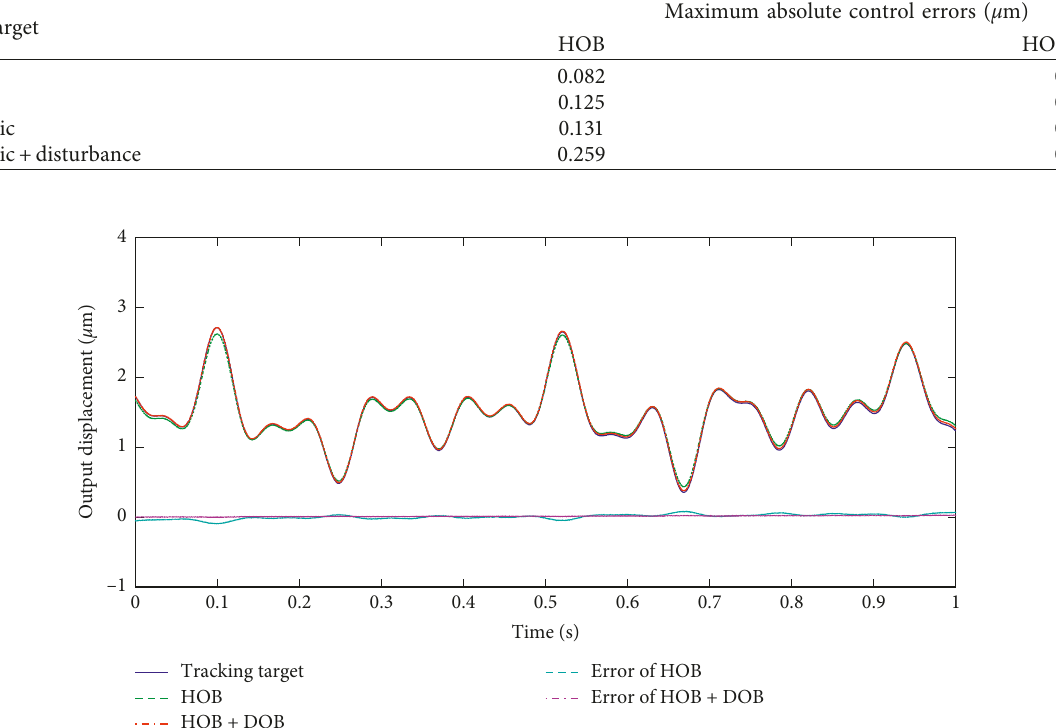
Figure 10: Control results in tracking a nonperiodical